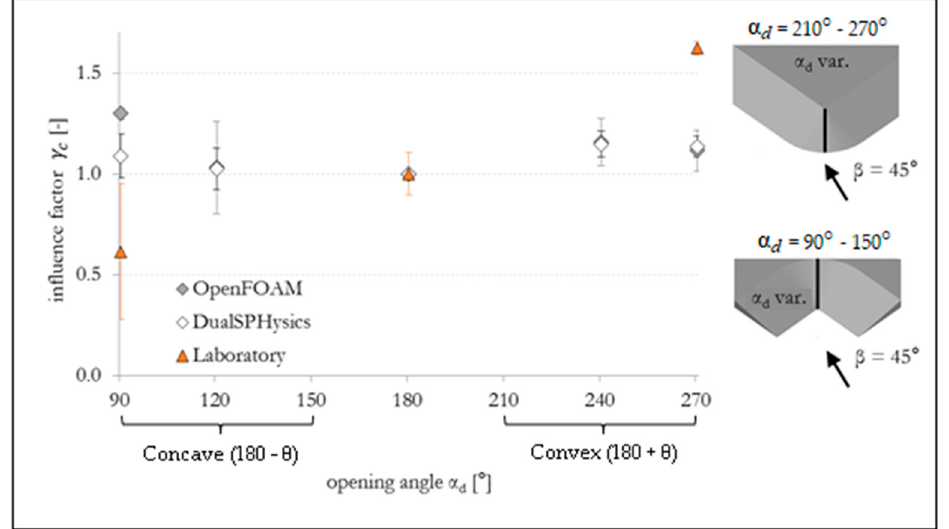
Figure 11. Influence of a curvature in the dike line on wave run-up for a 45° oblique wave attack–studied position: center of curvature.